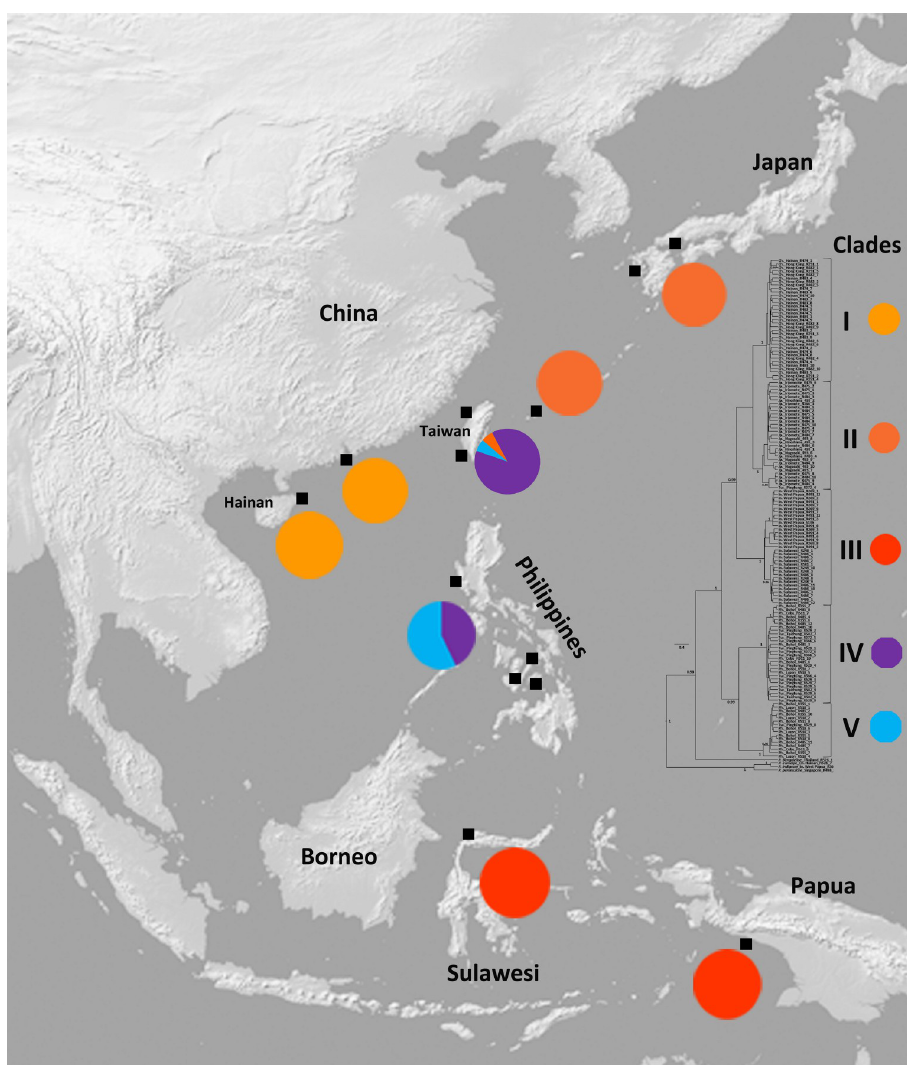
Fig 1. Sampling localities. Localities for materials of the present study (solid black squares) and distribution map of the five clades (from Fig 2B) comprised within the P . bidens complex, with percentages of each clade in each locality of the study. Map reprinted from Natural Earth (public domain) [http://www.naturalearthdata.com/] under a CC BY license.